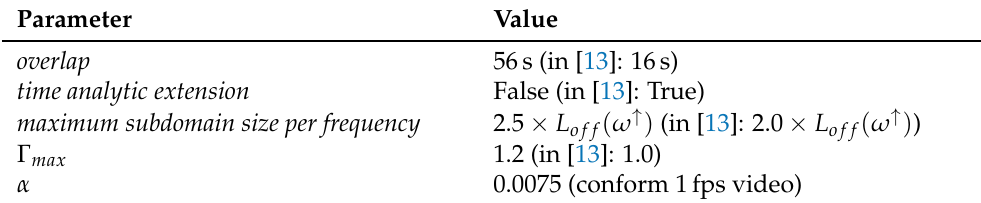
Table A1. Default parameter values of the depth inversion algorithm